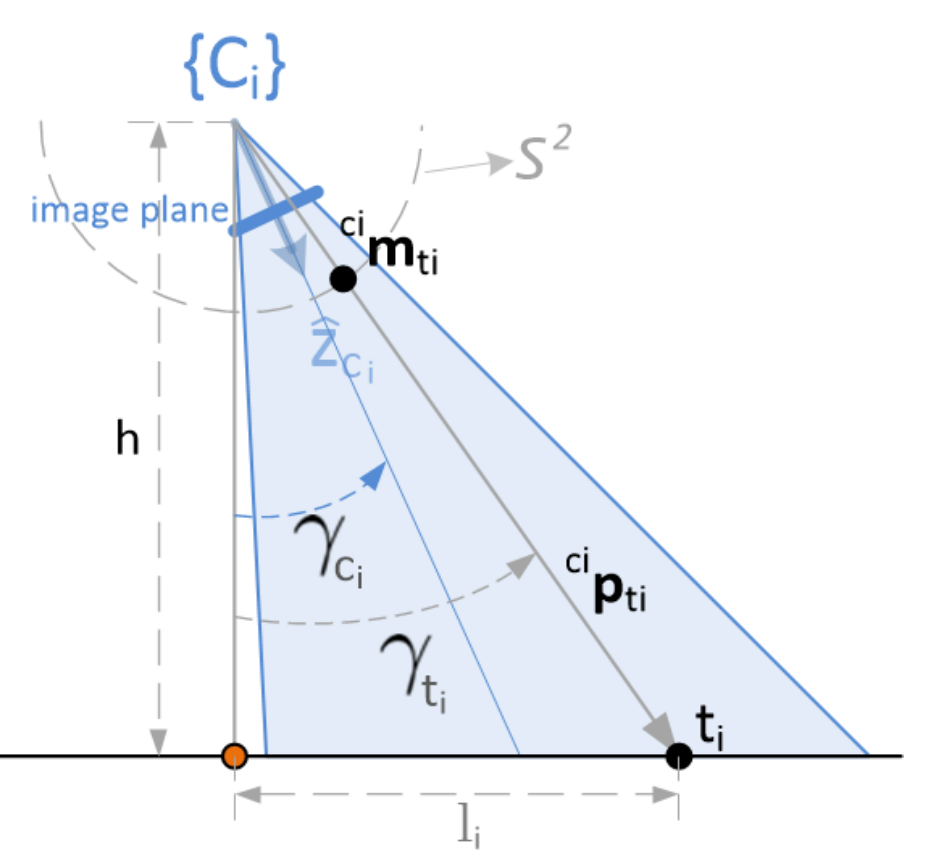
Figure 4. Relation altitude–verticality of the projected target